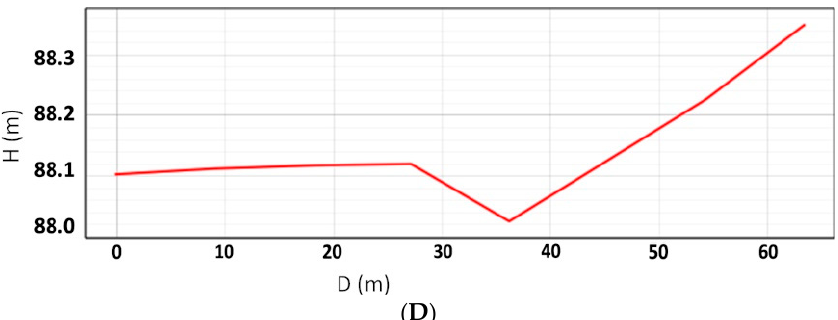
Figure 11. DTM extracted from REMA [40]. The red arrows of figure ( A , C ) represent the 2D rate of movements shown in Table 1 (ICF1, 591.964 m/yr; DRY1, 543.447 m/yr); ( B , D ) are REMA vertical profiles from the line of movements with azimuth 41.80°N (ICF1) and 101.17°N (DRY1).